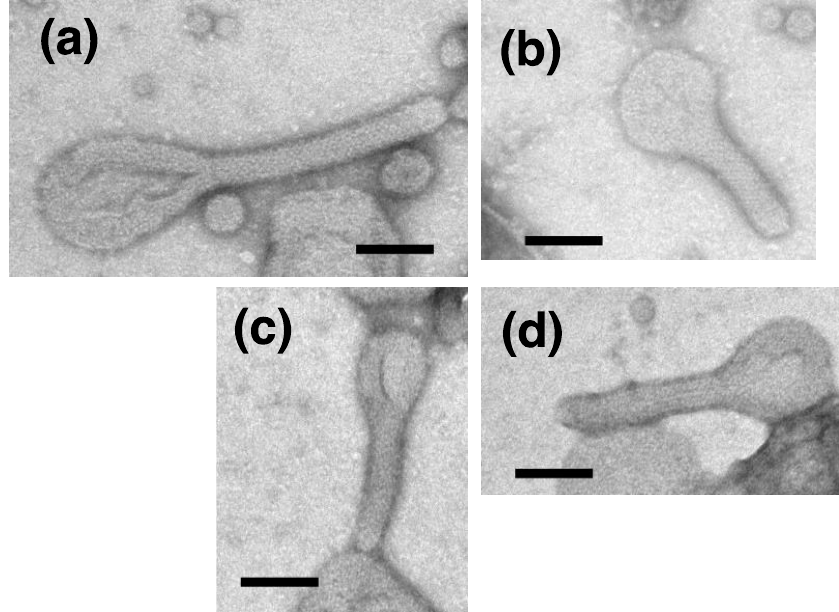
Figure 10. SR vesicles in the presence of the Ca 2+ -ATPase inhibitor, thapsigargin. The SR preparation (0.3 mg of protein/mL) was incubated with 100 mM imidazol-HCl (pH 7.4) containing 0.12 M KCl, 5 mM MgCl 2 , 5 mM EGTA and 23 mM ATP with and without TG at 0 °C overnight. ( a , b ) Vesicles in the presence of DMSO (0.09% ( v / v )) without TG. Many vesicles had crystal-arrays of particles. ( c , d ) Vesicles in the presence of TG at the ratio of 5 nmol TG/mg SR protein, which is half the dose, required for completely inhibit the ATPase (see text for details). The vesicles did not have crystal-arrays. Thapsigargin disturbed crystal formation by the surface particles at 0.04 nM Ca 2+ . Scale bars: 100 nm.